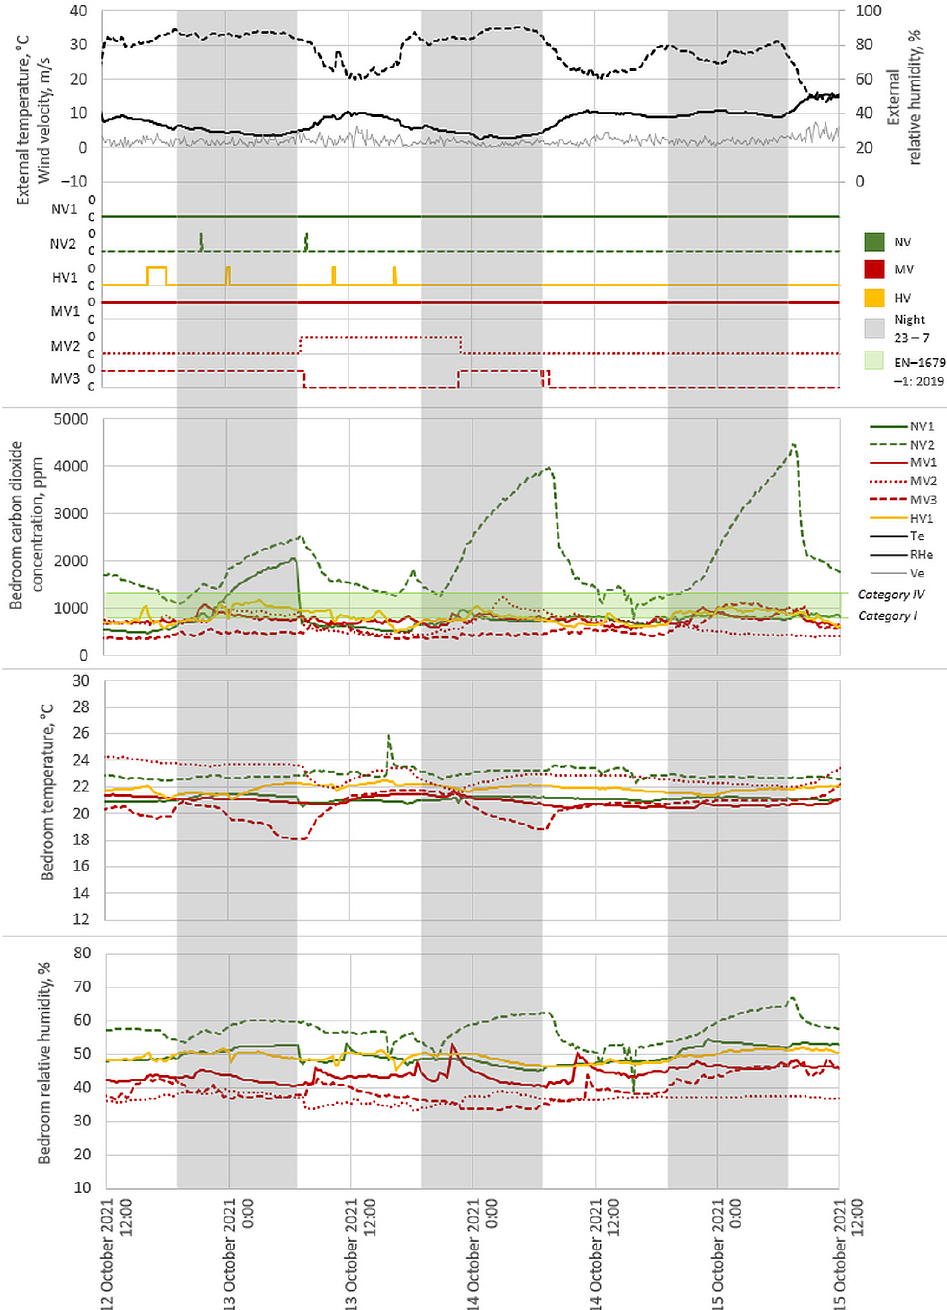
Figure 8. Detailed variability of the measured parameters over the period 12–15 October 2021.